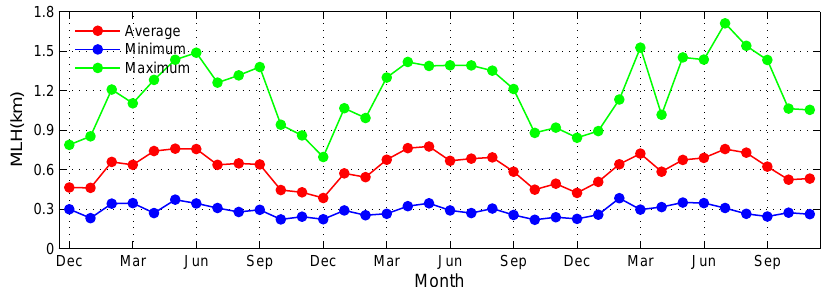
Figure 8. Monthly variations of the MLH from December 2009 to November 2012 in Beijing.